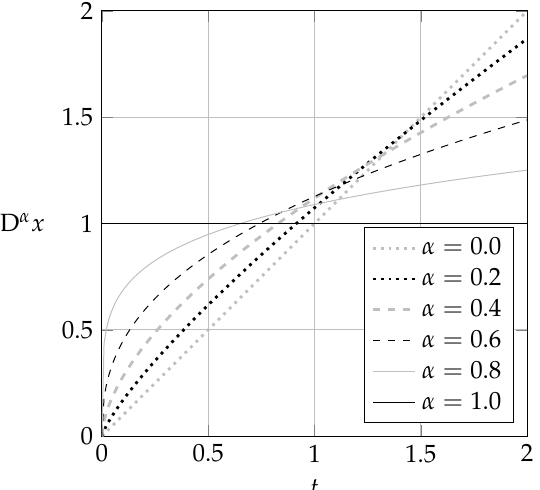
Figure 1. Fractional Caputo derivative of the linear function x ( t ) = t χ ( 0, ∞ ) ( t ) for various values of [ 0,1 ] α ∈